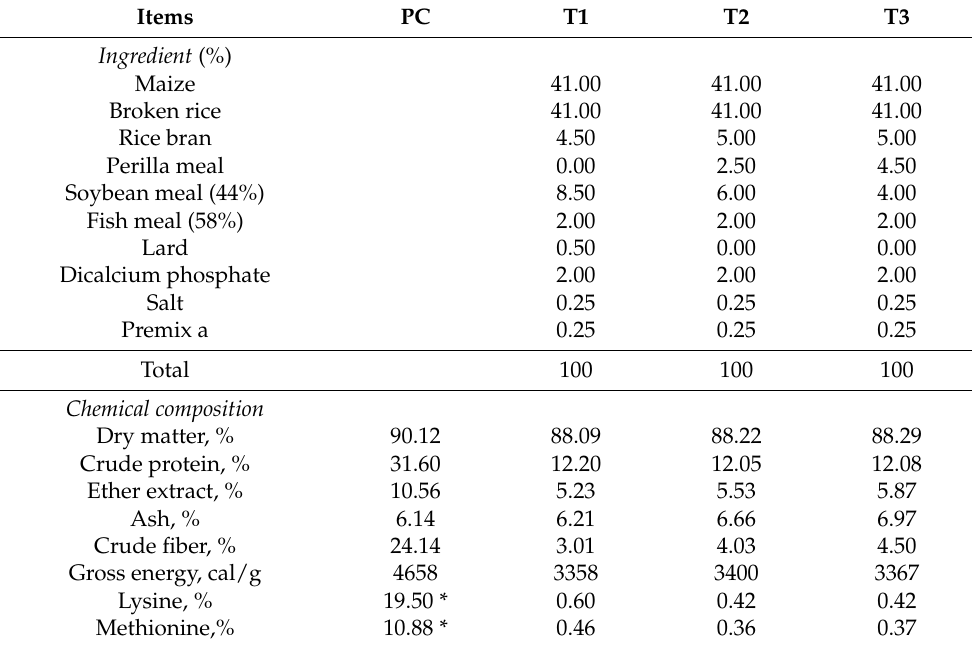
Table 1. Experimental diet formulations and chemical components (dry matter